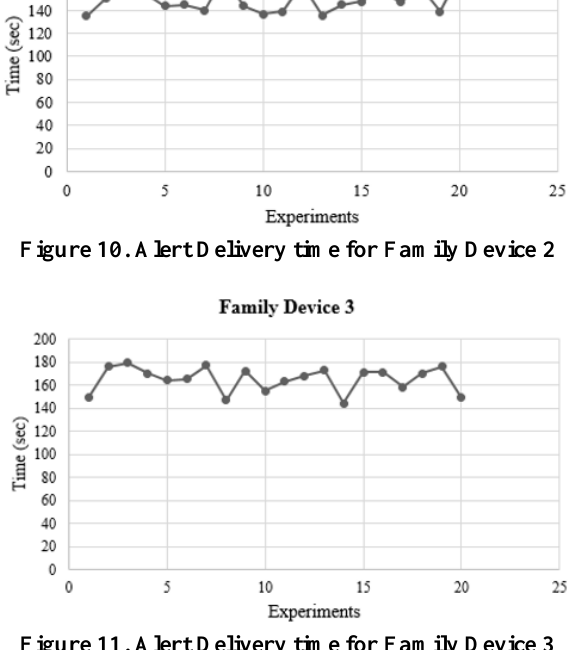
Figure 11. Alert Delivery time for Family Device